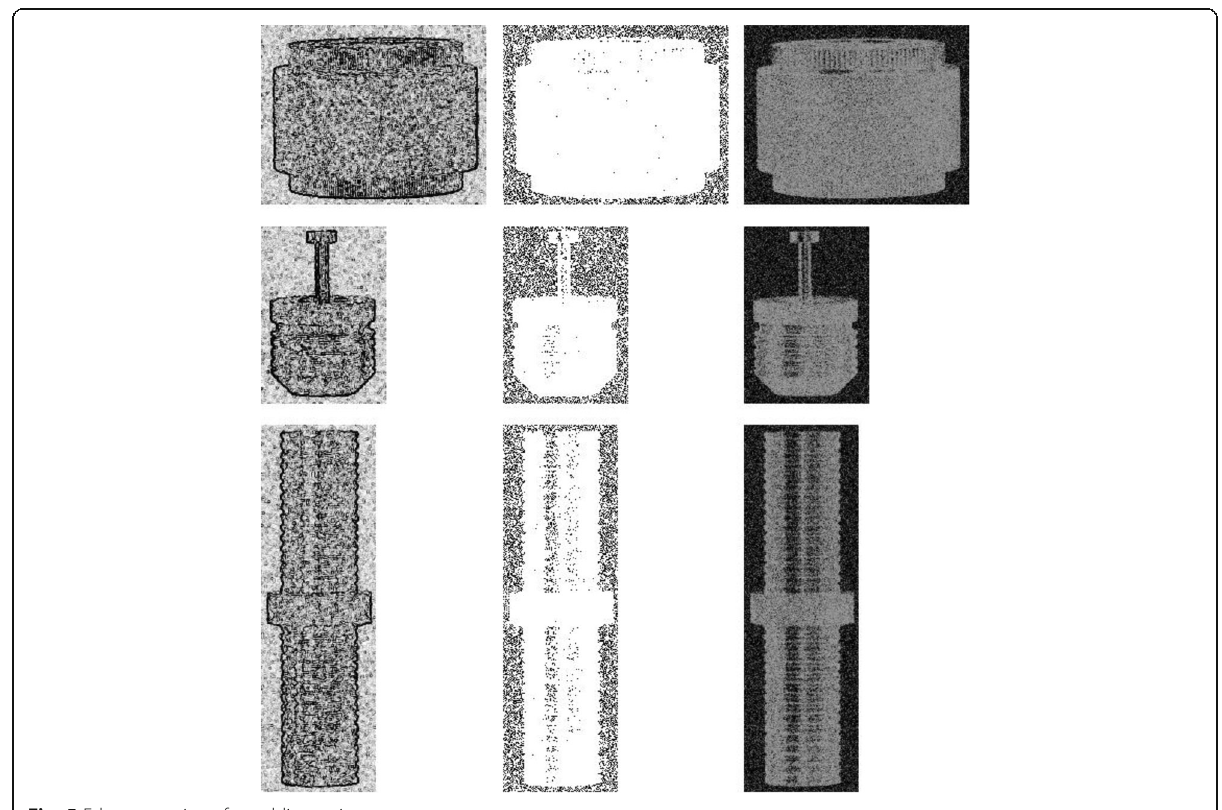
Fig. 5 Edge extraction after adding